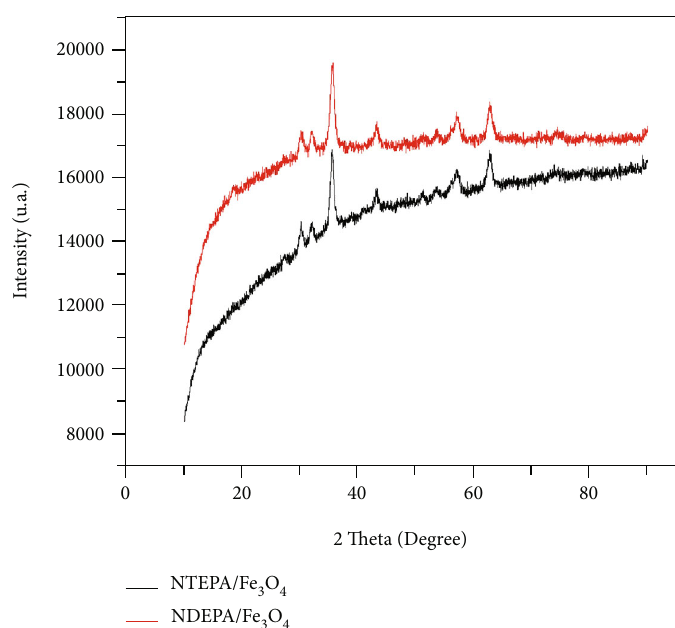
Figure 4: XRD di ff ractograms of NTEPA/Fe